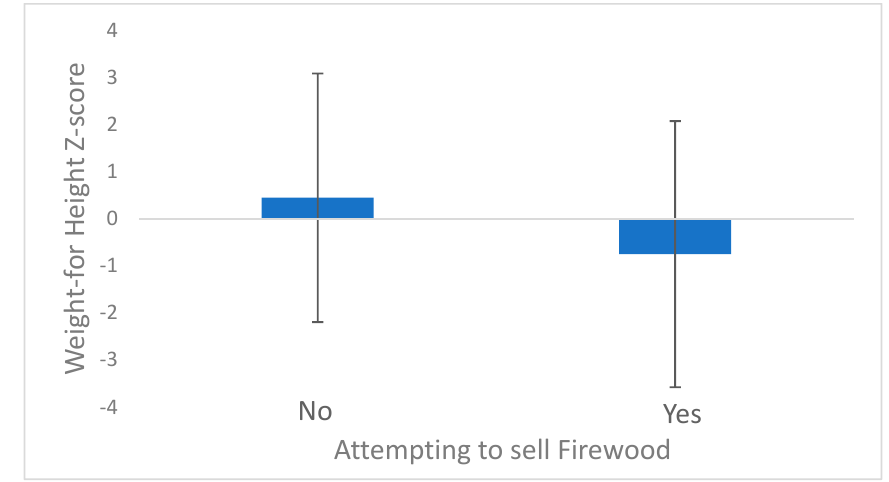
Figure 4. Weight for height z-scores for households that attempted to sell firewood and households that did not ( p = 0.045).